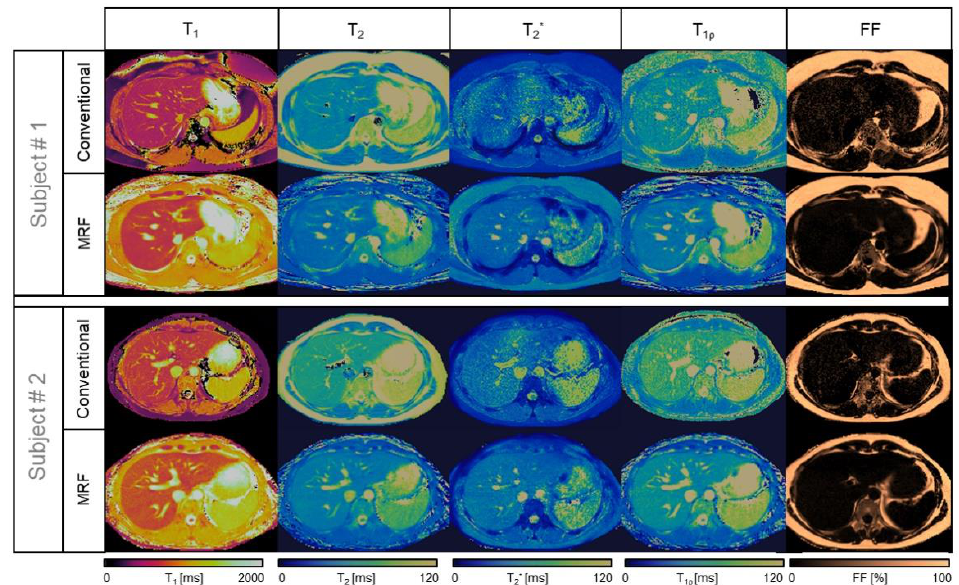
Figure 1. Comparison between liver MRF maps and conventional images from two healthy subjects. The conventional referencing sequences are ( top row, left to right for each subject) T1-MOLLI, T2- GraSE, 8-echo GRE T2 *, T1 ⍴ -TFE, and 6-echo GRE FF, compared against the proposed inherently co-registered T1, T2, T2 *, T1ρ , and FF abdominal MRF maps ( bottom row left to right for each subject) obtained from a single 18 s scan.